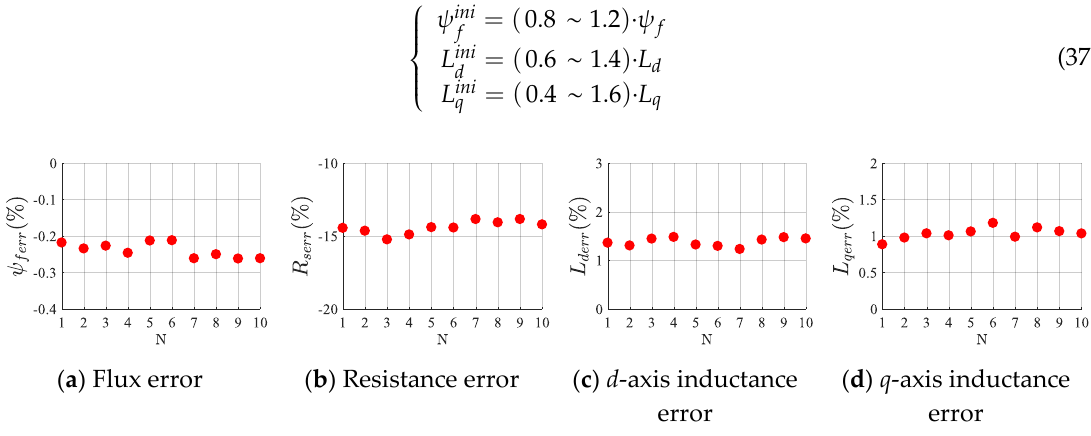
Figure 10. Experimental results with inaccurate initial parameters.